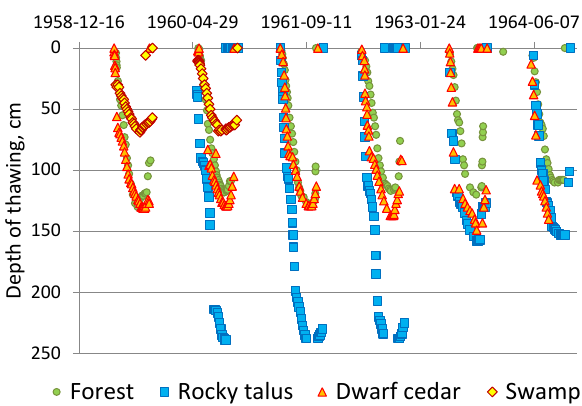
Figure 13. Depth of ground thawing at the different landscapes of the KWBS.